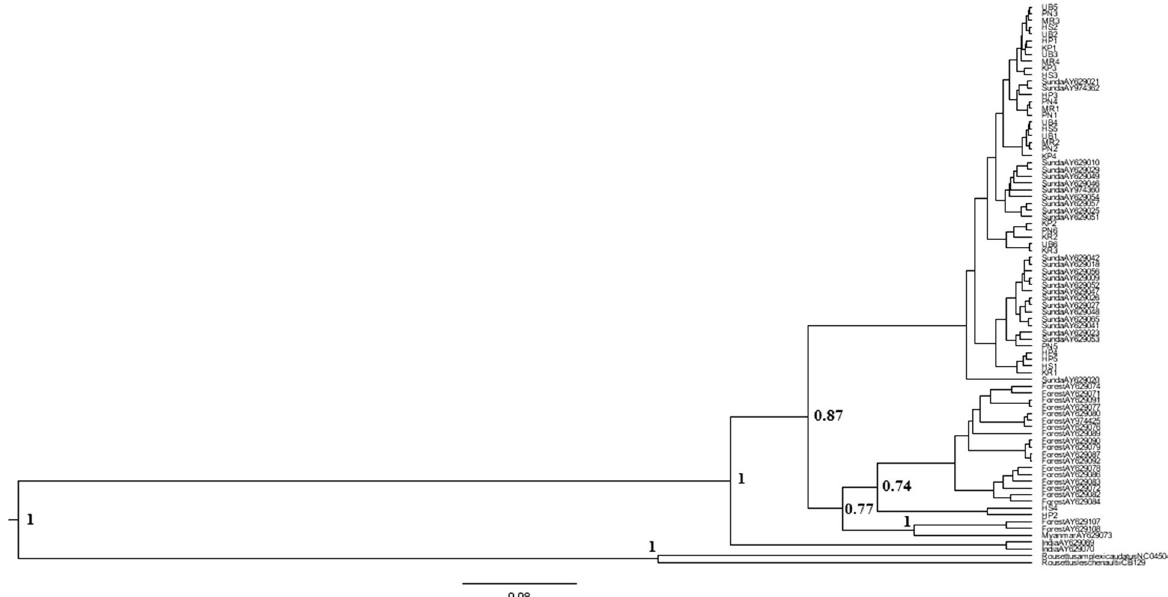
Fig. 2 Bayesian inference (BI) phylogenetic tree of Cynopterus brachyotis in this study and GenBank data based on the D-loop sequence. The number shown to the node indicates the Bayesian psterior probability value